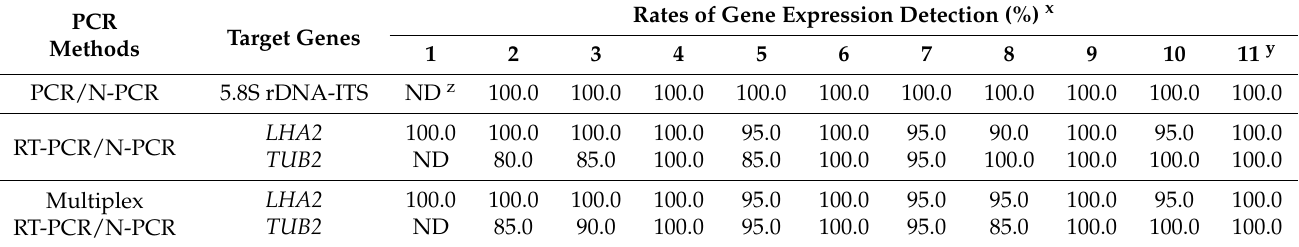
Table 2. PCR detection of gene transcripts in the intracellular contents of plant and/or fungal cells with single P. neolycopersici -non-inoculated/inoculated leaf type I trichomes of tomato ( Solanum lycopersicum Mill. cv. Moneymaker).